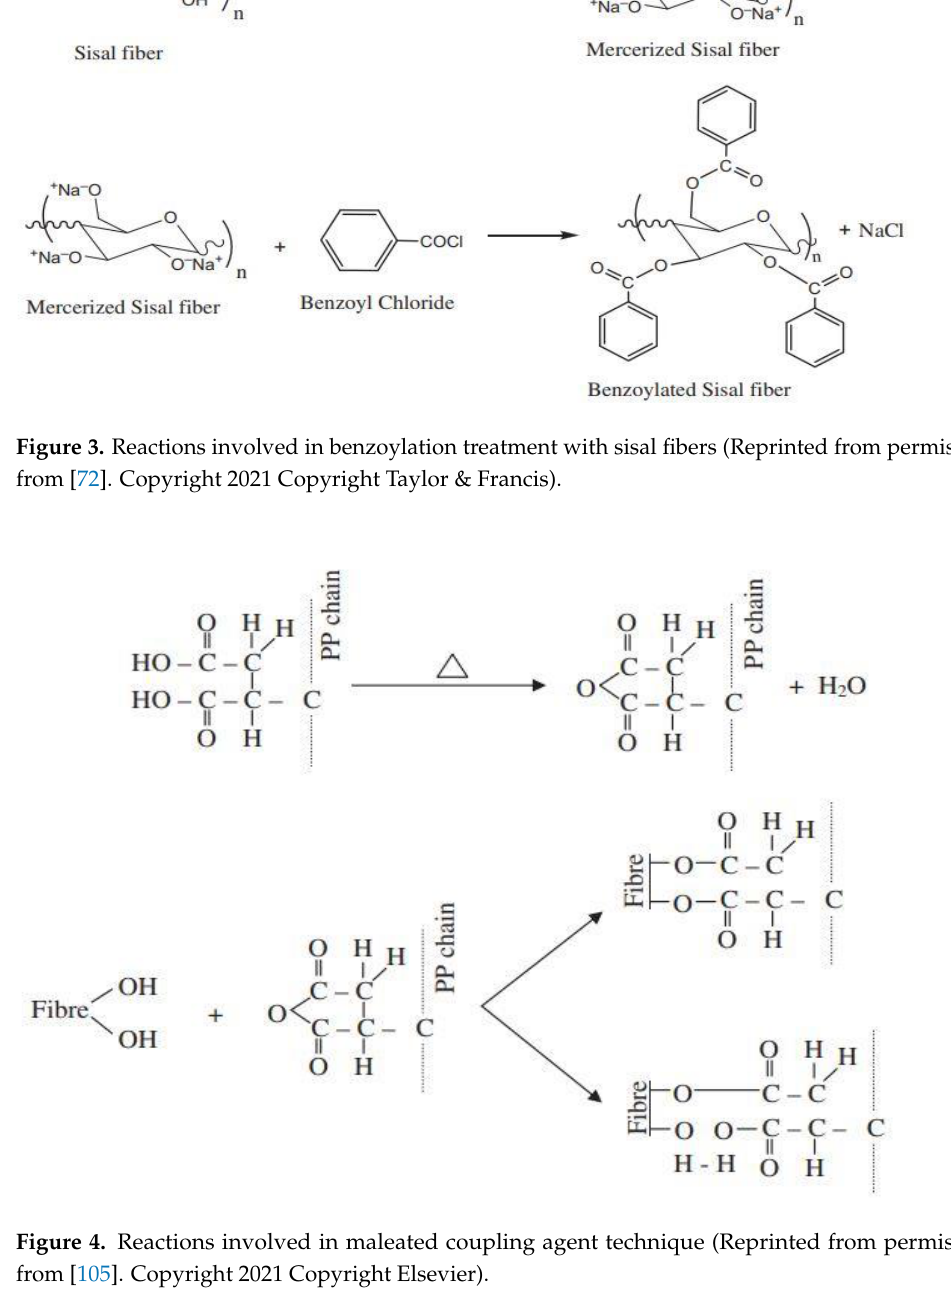
Figure 3. Reactions involved in benzoylation treatment with sisal fibers (Reprinted from permis- sion from [72]. Copyright 2021 Copyright Taylor & Francis).